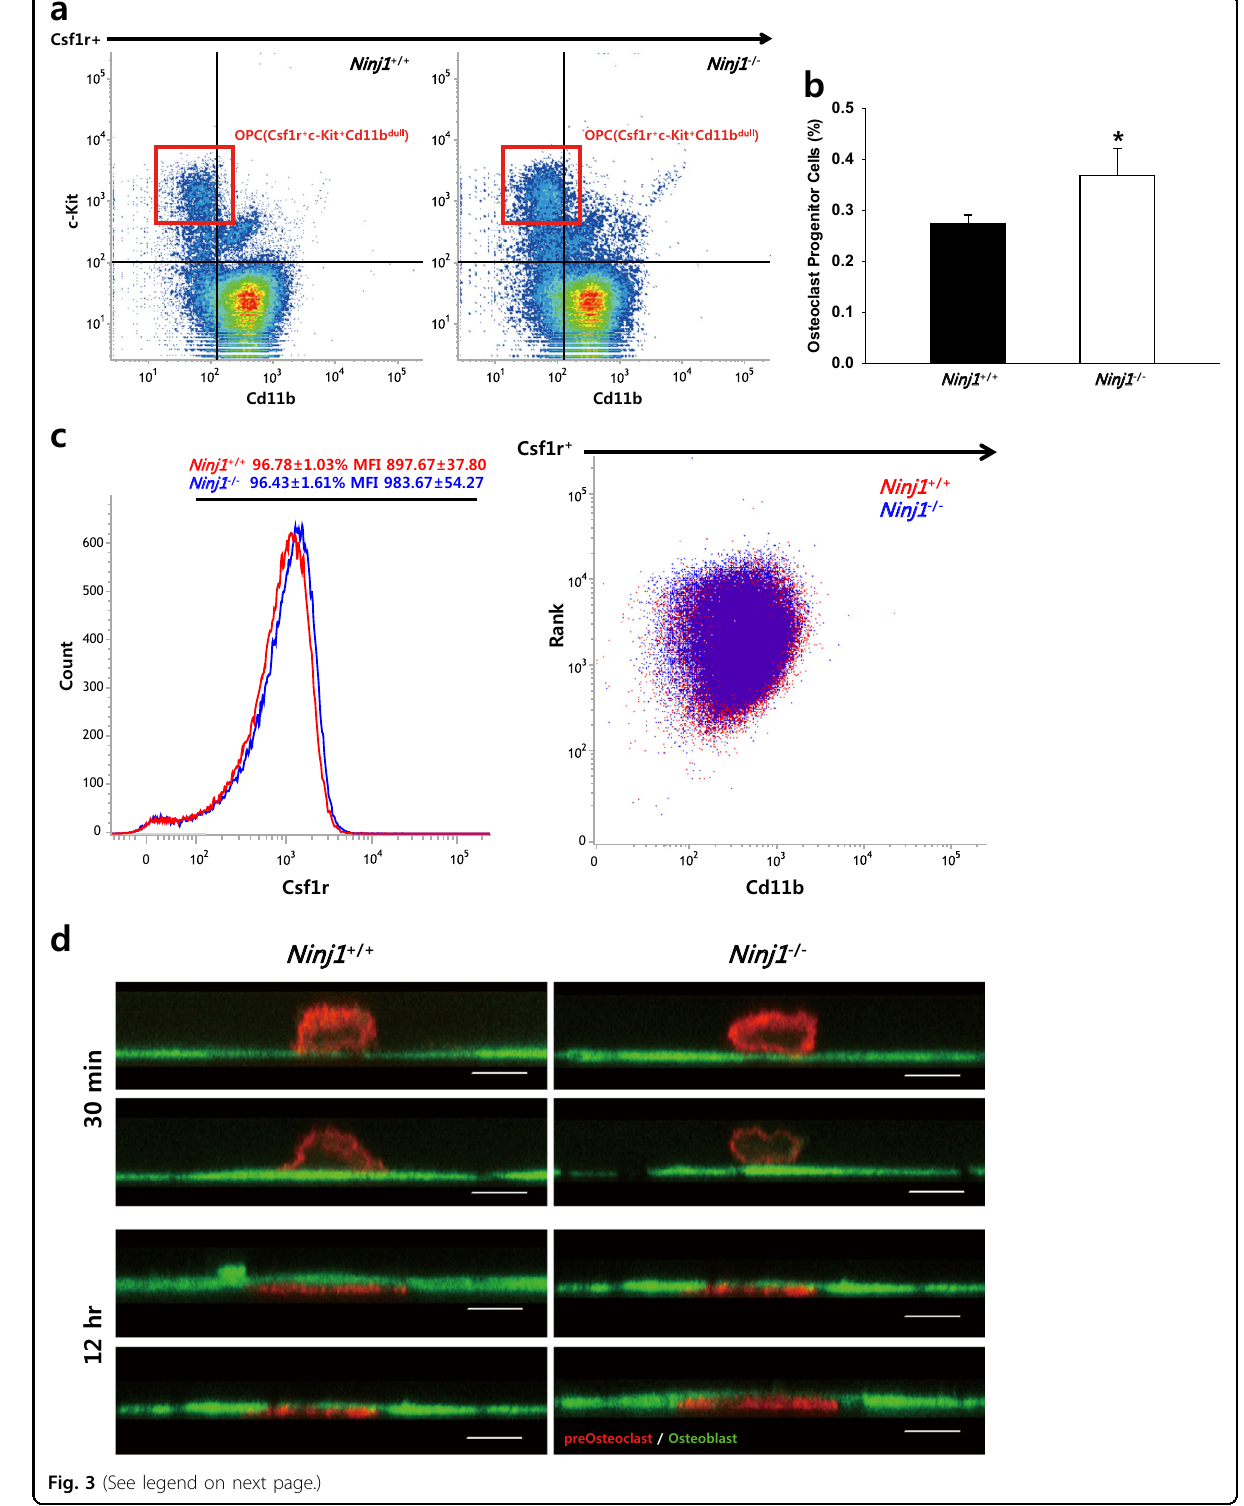
Fig. 3 (See legend on next